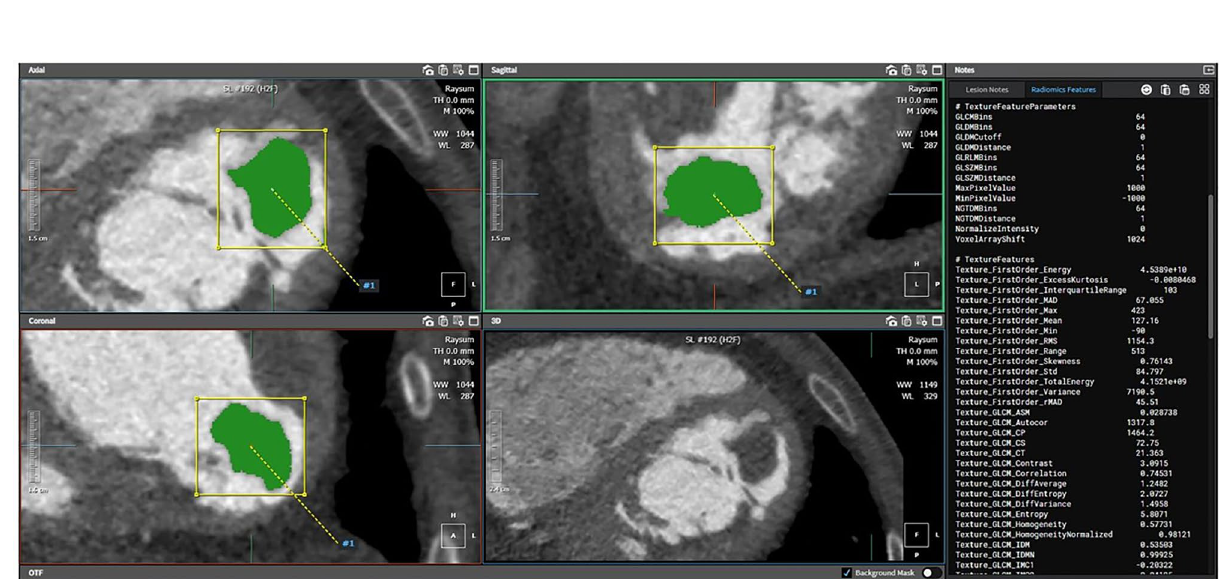
Figure 6. A 53-year-old man with cardiac myxoma in the left atrium. A lobulated mass (43 mm) in the left atrium. The predictive probability of tumor based on radiomics features of this mass was